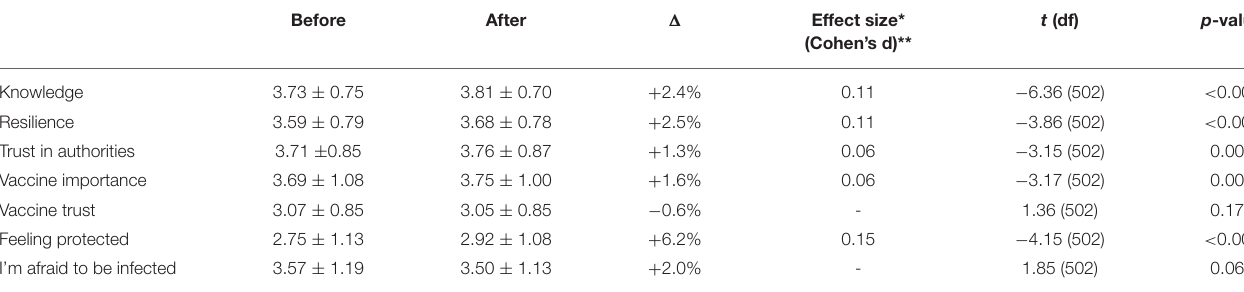
TABLE 2 | Average scores before and after viewing the vaccination video.